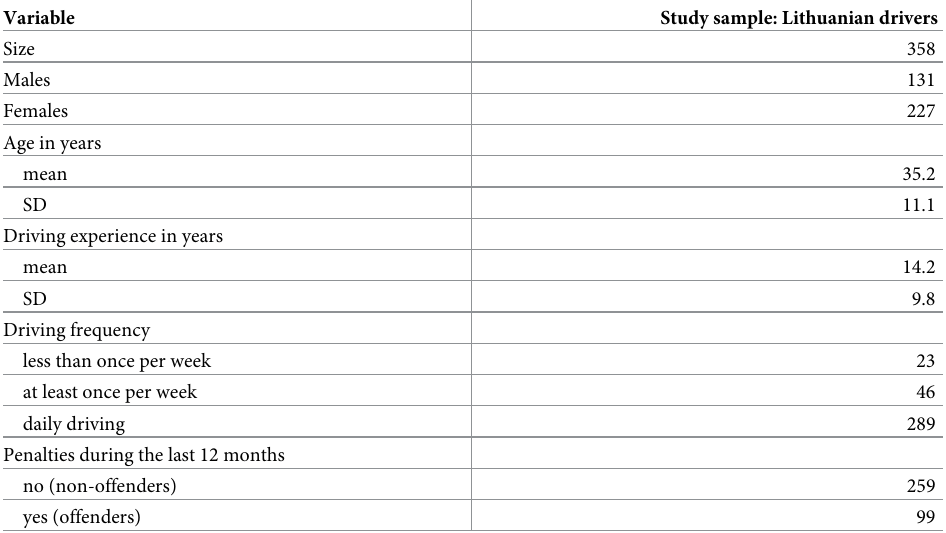
Table 1. Sociodemographic information of study